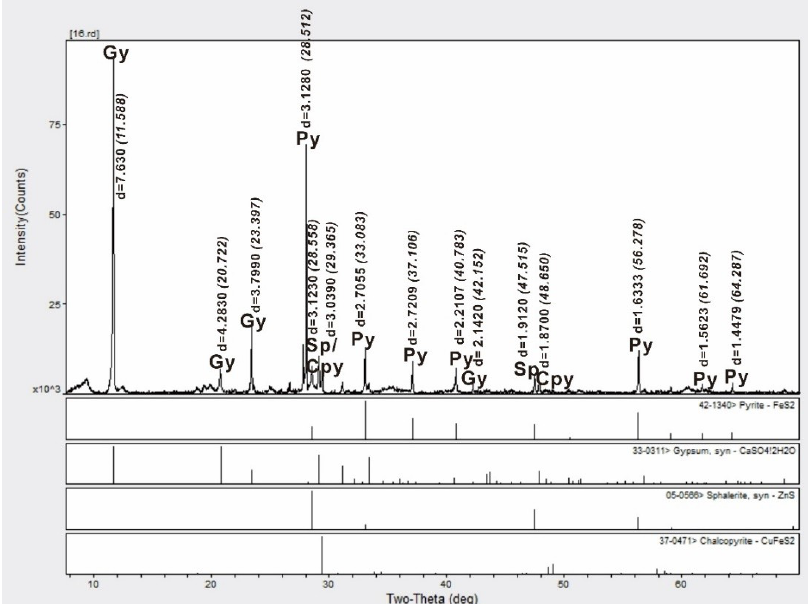
Figure A2. Bulk XRD patterns of representative samples of Wocan-1 (station 28I-TVG07); the 2θ values are enclosed in the bracket, whereas, the first values are the d values. Characteristic peak values were compared with References [35,36]. Abbreviations Sp: sphalerite; Cpy: chalcopyrite; Py: pyrite, Gy: Gypsum.